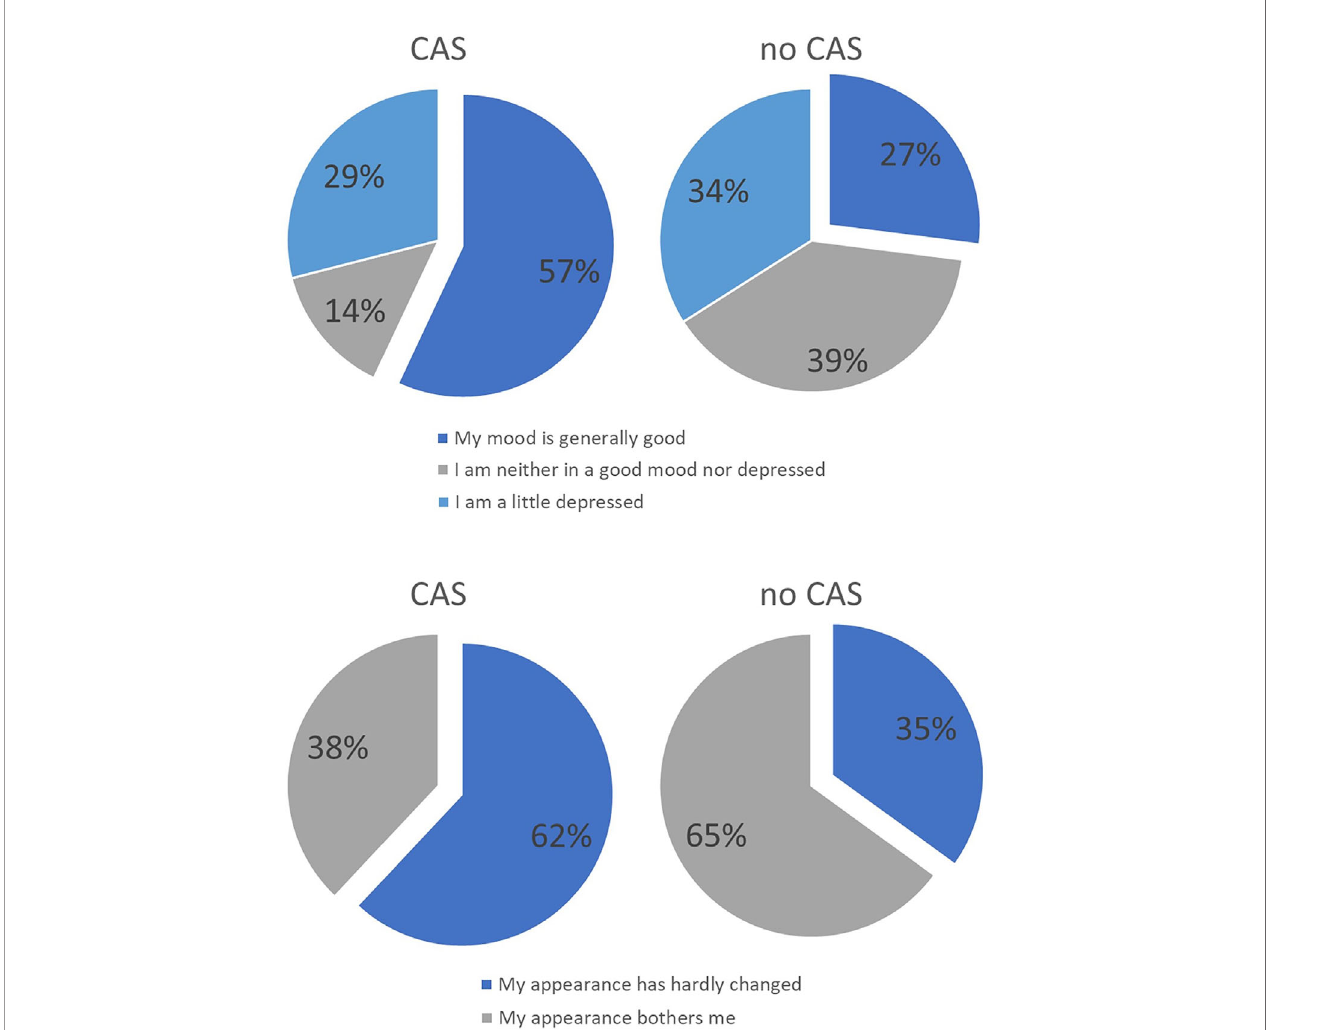
FIGURE 12 | Distribution of answers of the intervention group treated with CAS compared to the control group treated without CAS. In the upper part distribution of answers regarding the question of the mood in recent weeks are displayed while in the lower part distribution of answers regarding the question of ‘ how you feel about your own external appearance in recent weeks ’ are